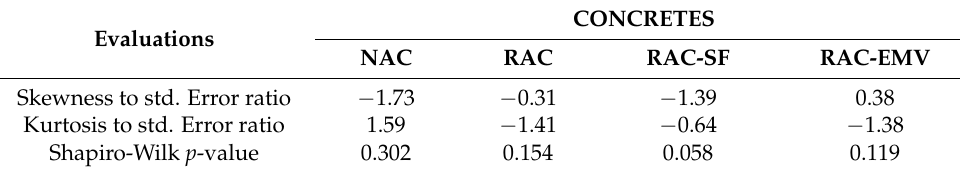
Table 8. Shapiro-Wilk normality test results.